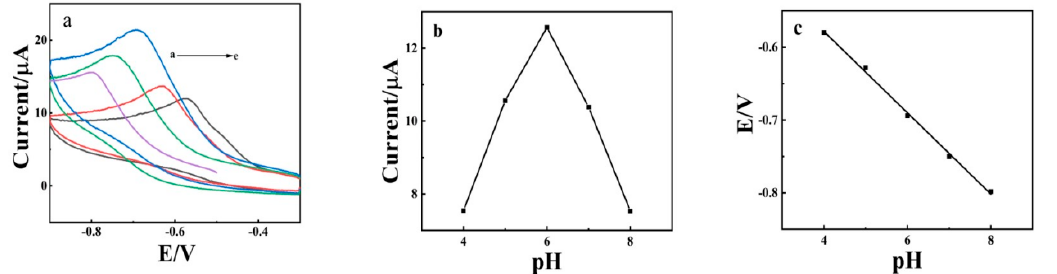
Figure 8. ( a ) Cyclic voltammograms of CLR-PC/GCE in 100 μ mol·L − 1 4-NP at pH of 4.0, 5.0, 6.0, 7.0 and 8.0. Scan rate: 100 mv·s − 1 . ( b ) Plot for the relationship between pH and peak current, and ( c ) plot for the relationship between pH and E pc .